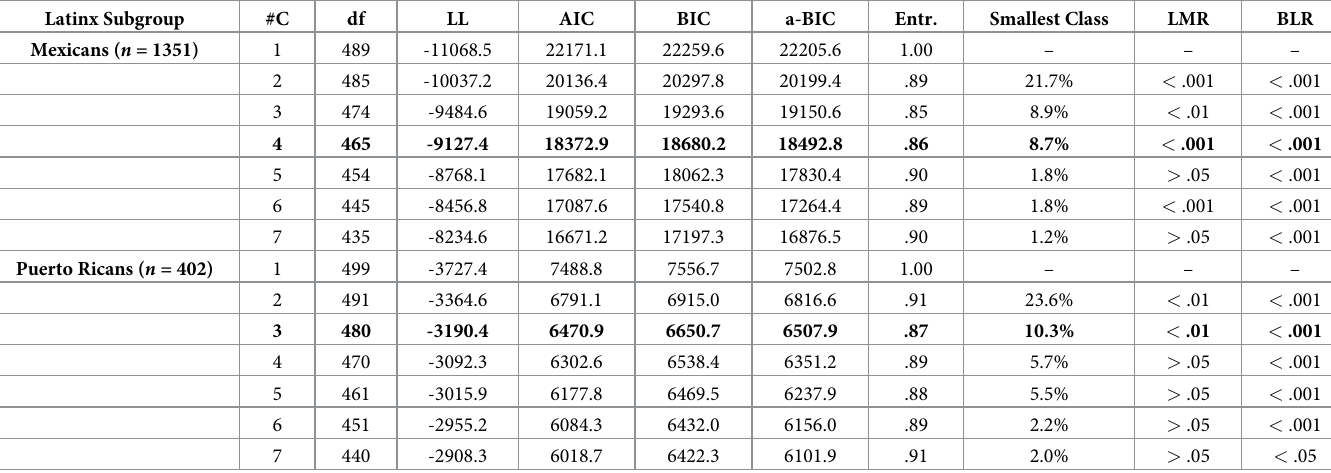
significant for all profile solutions for both ethnic groups. For Mexicans, the three-, four- and five- profile solutions had comparable fit indices. We favored the four-profile solution over the three-profile solution because of the emergence of a distinct, conceptually meaningful fourth profile (i.e., ACEs Only) and over the five-profile solution because the fifth profile was small (less than 5% of the sample), which can lead to less reliable parameter estimates and limits the relevance of this subgroup [67, 68]. Moreover, the fifth profile was not conceptually distinct from the Dual Exposure profile. The six- and seven-profile models had profiles that were even less prevalent than the five-profile model and significant LMRT statistics, indicating worse fit. Therefore, for Mexicans, we selected the four-profile solution as the best fit to the data. Table 4. Model fit statistics & selection criteria for Mexicans and Puerto Ricans. Latinx